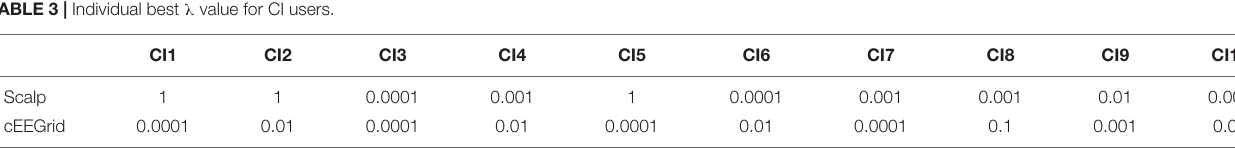
TABLE 3 | Individual best λ value for CI